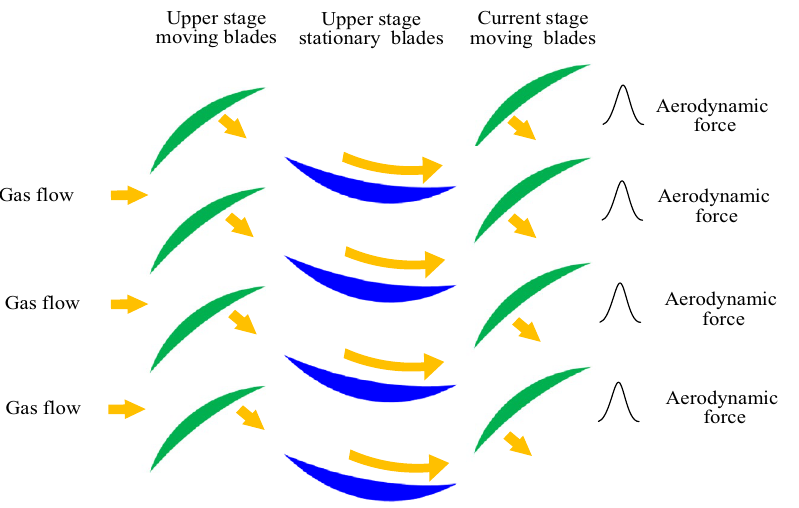
Figure 4. Schematic diagram of aerodynamic force between moving blade and stationary